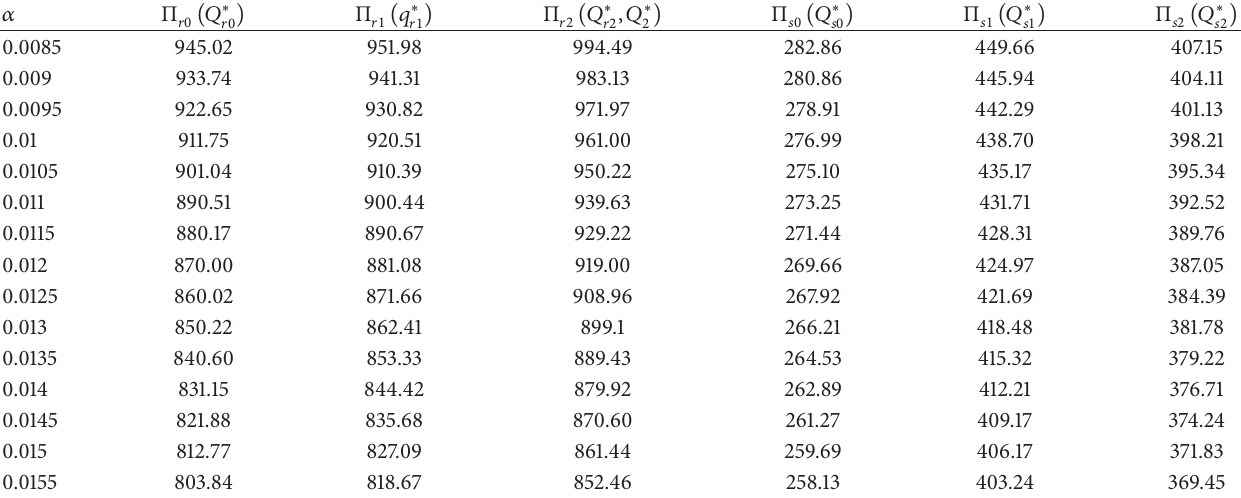
Table 6: The impact of 𝛼 on the optimal expected